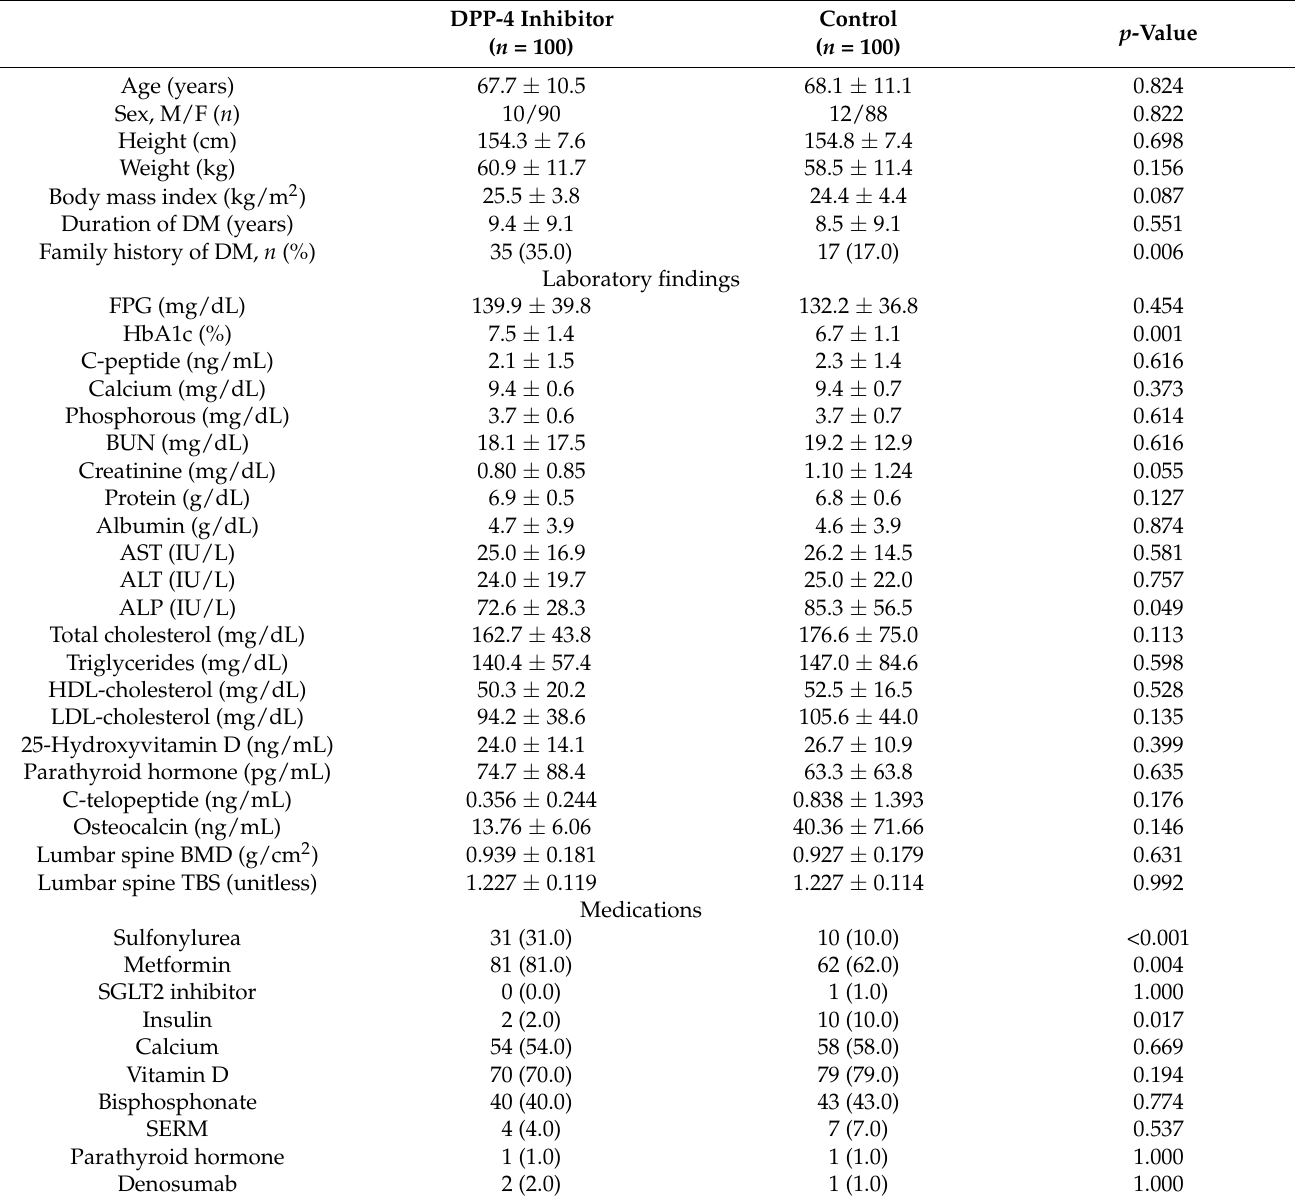
Table 1. Baseline characteristics of the study population.